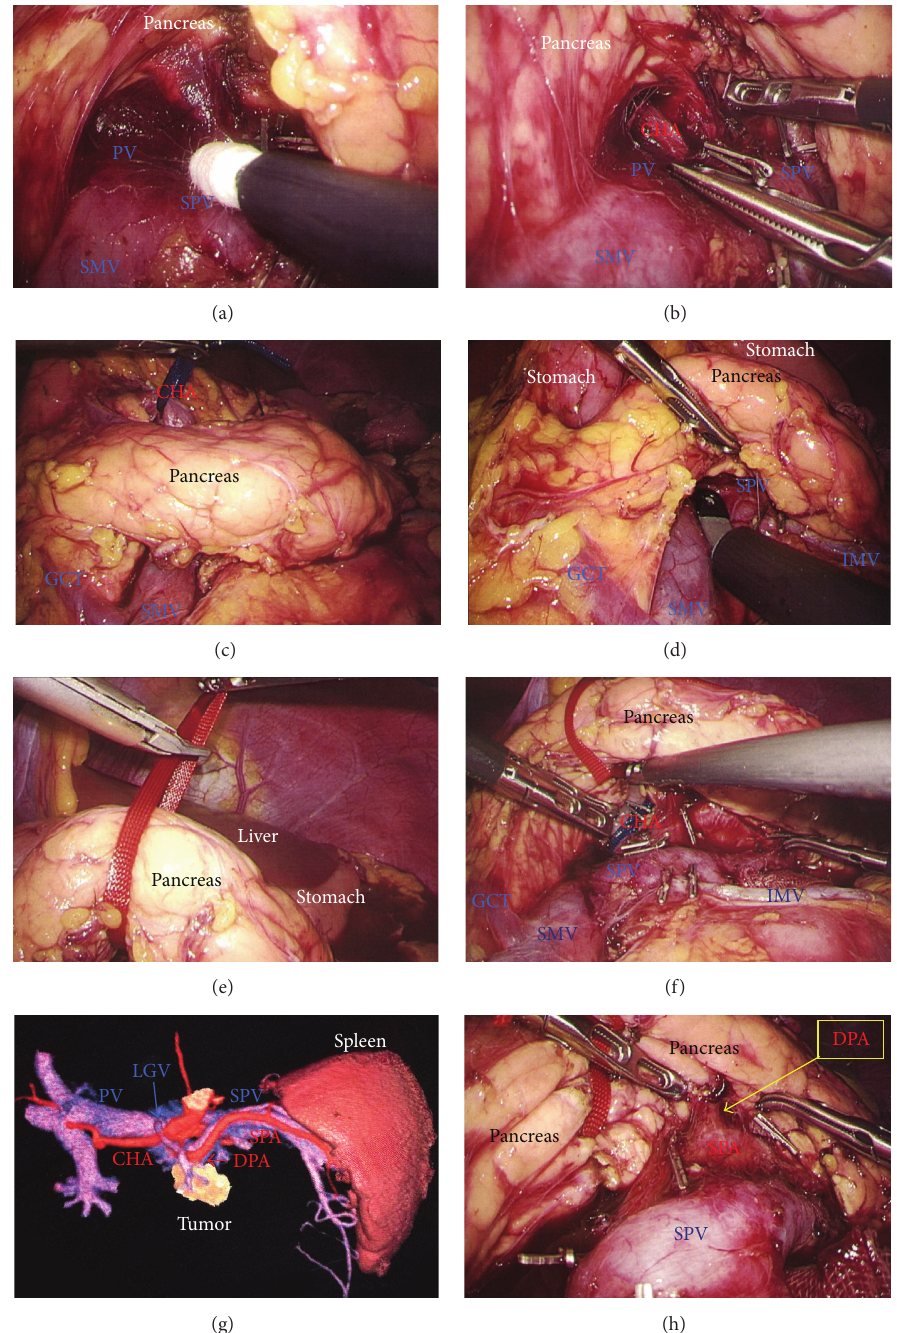
Figure 6: (a) The anterior wall of the SMV and PV was carefully and completely separated from the pancreatic parenchyma. (b) and (c) Tunneling of the pancreas was then performed at the level of the PV and SMV. (d) and (e) The pancreas was taped for retraction. (f) Sufficient tension was created using the forceps shaft. (g) Three-dimensional imaging revealed that the DPA branched from the SPA near the tumor. (h) The DPA was visualized. DPA, dorsal pancreatic artery; PV, portal vein; SMV, superior mesenteric vein; SPA, splenic artery.